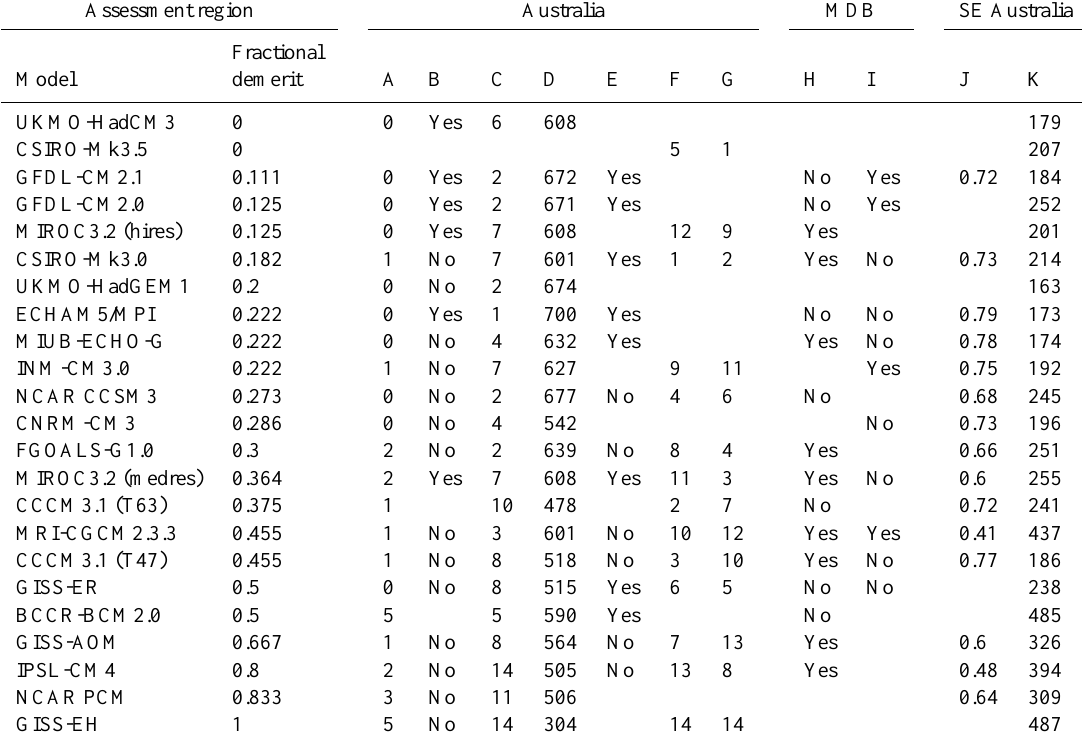
Table 2. Summary of CMIP GCM assessments. Assessment